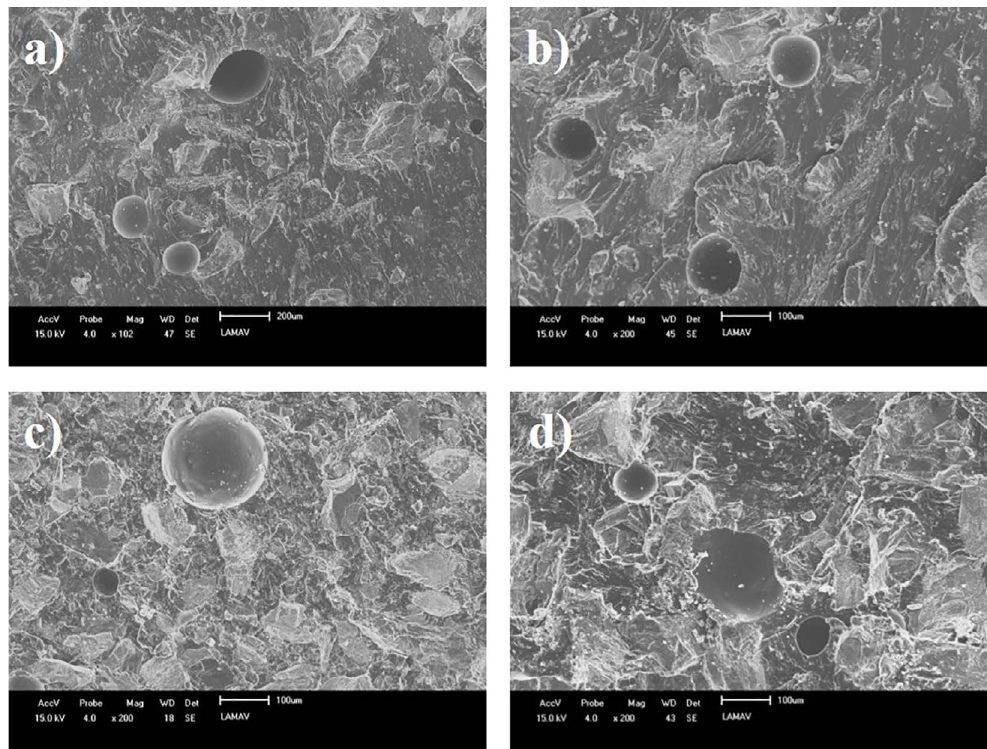
Figure 4. SEM micrographs of the artificial rocks produced with chicken eggshell waste (< 60 mesh): a) 50/50; b) 55/45; c) 60/40; and d) 65/35.